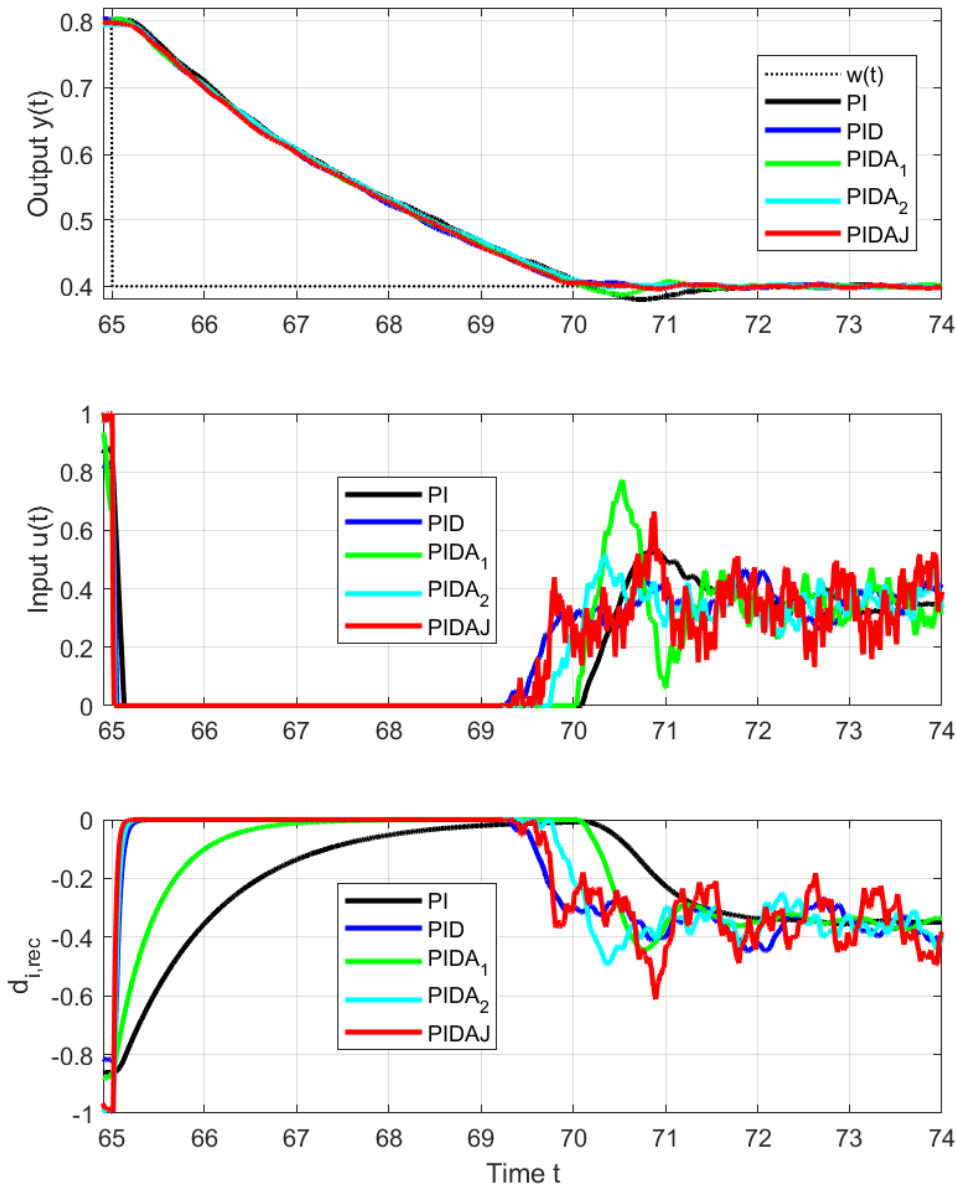
Figure 6. Details of setpoint step responses from w = 0.8 to w = 0.4 at t = 65 s. The use of controllers with higher-order derivatives, in general, leads to a reduction of the initial overshoot PO through the setpoint value and to an acceleration of transient responses, including disturbance reconstruction. However, it leads simultaneously to increased oscillation of the output and the input around the steady states (increasing TV 1 ( u ) values). For the PIDAJ controller, the amplitude of permanent oscillations is already greater than the initial overshoot caused by limiting the control signal during the transient response. Therefore, when it comes to the smoothest possible alignment of transient responses and steady states, we obtain a result similar to conclusion [30]—the order of the used filter should be chosen as n ≥ m +